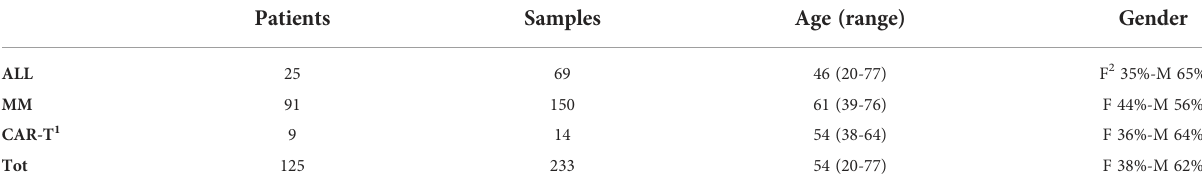
TABLE 1 Patients ’ overview. Three main sub-groups of patients have been included in the study: Acute Lymphoblastic Leukemia (ALL) patients, Multiple Myeloma (MM) patients and MM patients treated with chimeric antigen receptor (CAR)- T cells.